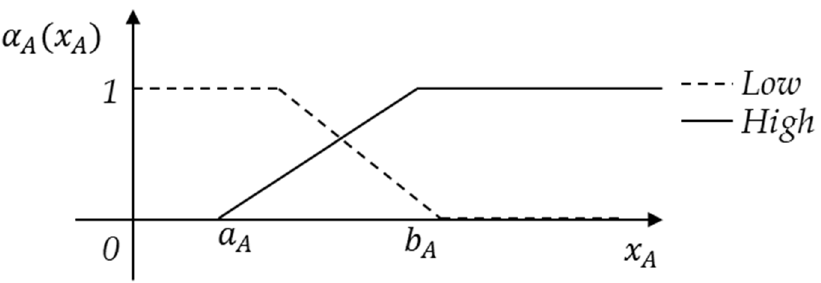
Figure 7. The membership function of the linguistic variable availability of the processing system.